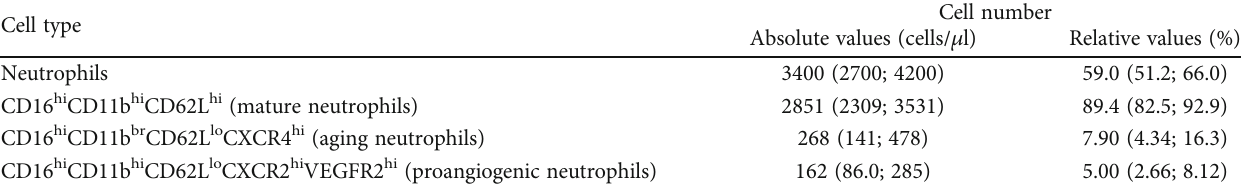
Table 2: Results of fl ow cyto fl uorometry showing neutrophil subpopulation